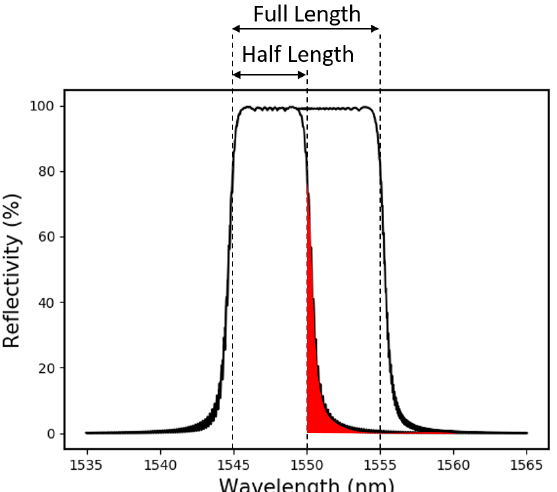
Figure 6. Simulation showing a high reflectivity CFBG spectrum (10 nm bandwidth, 99% reflectivity) when the grating is fully intact and when it has been cut in half. The section in red highlights the asymmetry which causes the reflected power to be front-loaded. This slight billowing out of the spectrum must also be considered when techniques are used that determine a gratings length from its bandwidth (directly).